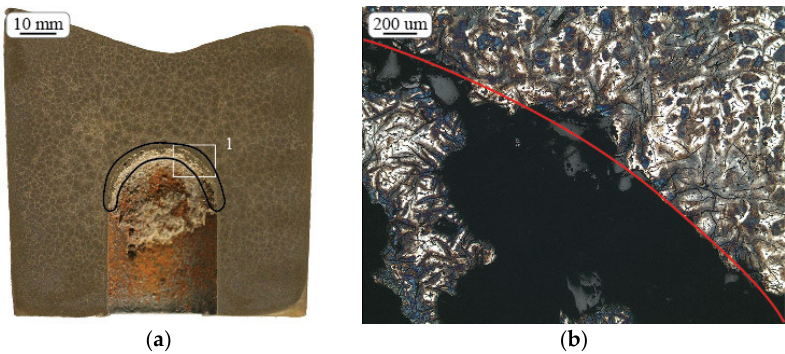
Figure 8. ( a ) Polished surface of the MEP sample; ( b ) Color ‐ etched micrograph from the MEP sample. Primary austenite appears in dendritic shape with brownish blue color above the red line. The simulated local solidification time in the MEP sample is illustrated in Figure 9. The last solidification time is found adjacent to the internal concave casting surface. The largest local hydraulic diameters in the MEP sample are found in the same positions as the slowest solidification time. A comparison of micrographs collected from positions with different solidification time indicate the morphological differences (see Figures 10 and 11).